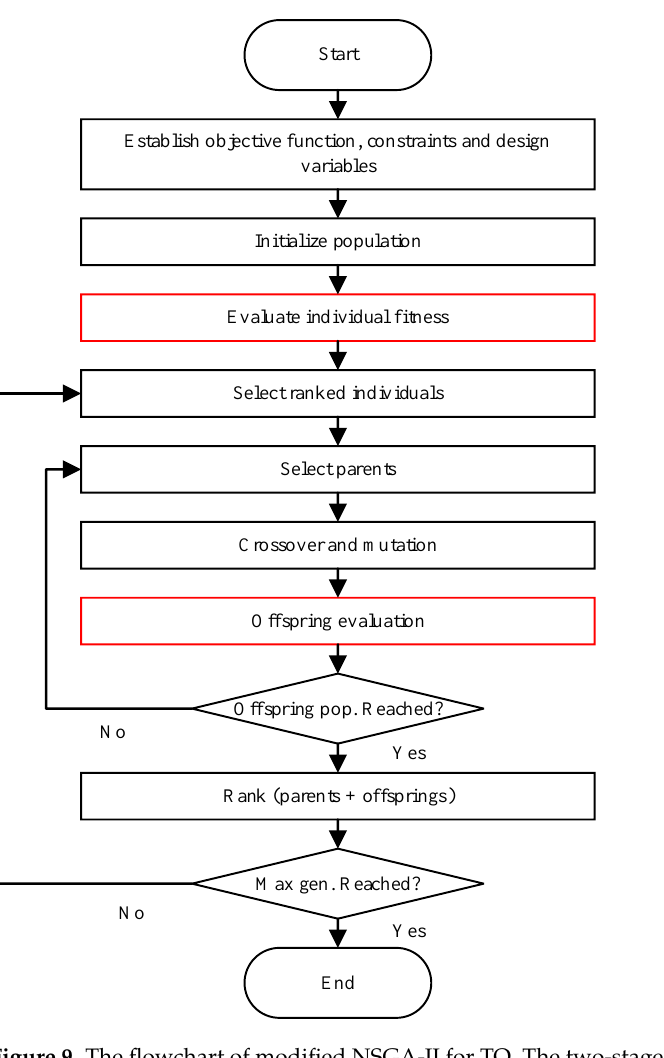
Figure 9. The flowchart of modified NSGA-II for TO. The two-stage simulation is performed in the evaluation process in the red box.